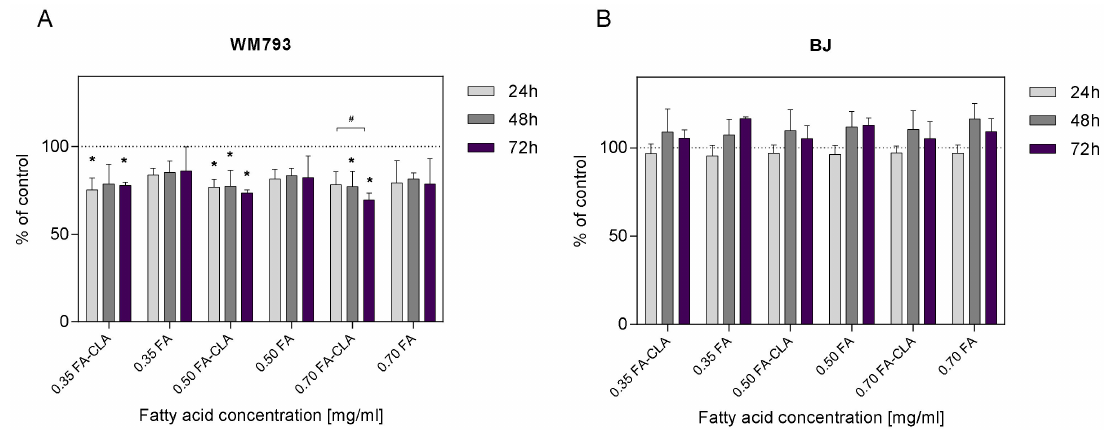
Figure 2. Effect of a mixture of fatty acids extracted from CLA-enriched and non-enriched yolks on the proliferation of human cancer cells of line WM793 ( A ) and normal line BJ ( B ). Statistical significance of differences was assessed using the Mann–Whitney U test at a significance level of p ≤ 0.05. The results are presented as mean, ± SD for n = 15. *—Differences statistically significant relative to the control sample, # —differences statistically significant between time